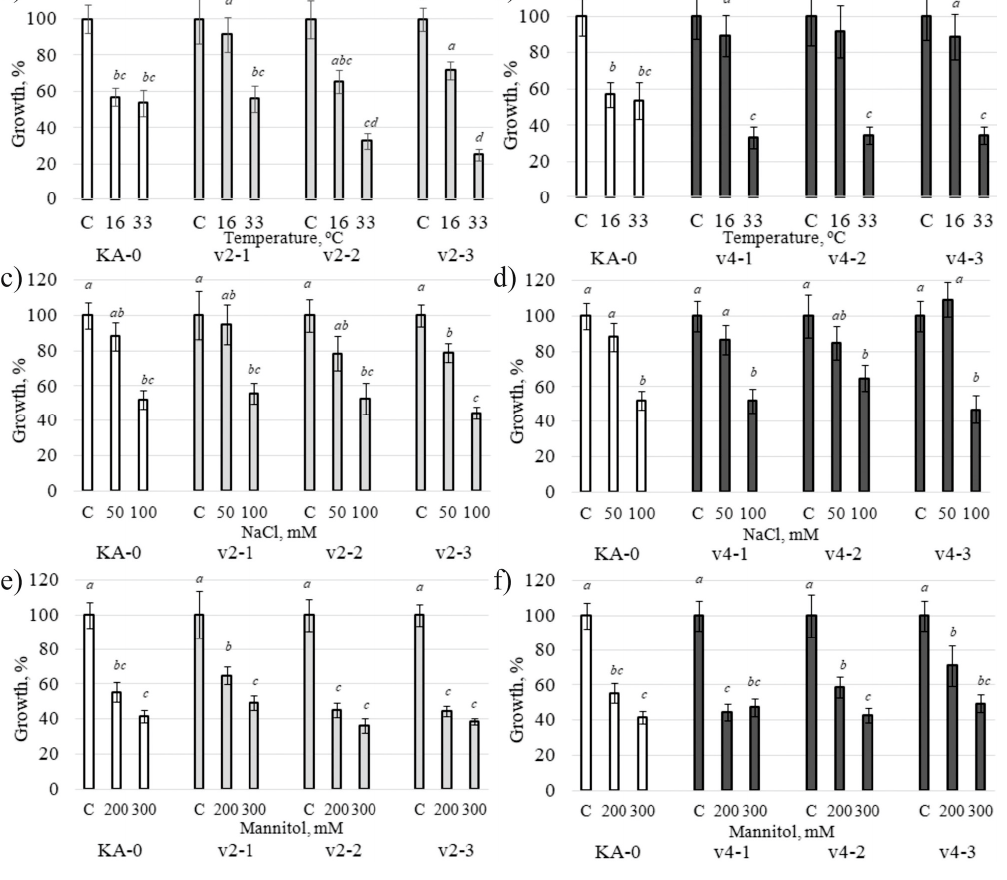
Figure 6. Influence of temperature ( a , b ), salt ( c , d ) and osmotic ( e , f ) stresses on the fresh biomass accumulation in the transgenic grapevine callus cell lines overexpressing the VaCML21v2 and VaCML21v4 splice variants. The average growth rates were assessed after 30 days of cultivation in the dark under the control (24 °C), cold stress (+16 °C), heat stress (+37 °C), salt stress (NaCl 50 and 100 mM), and high-mannitol (200 and 300 mM) conditions. v2-1, v2-2, v2-3— VaCML21v2 -transformed calli; v4-1, v4-2, v4-3— VaCML21v4 -transformed calli. KA-0—control cell culture transformed with the “empty” vector. The data are presented as the mean ± SE (two independent experiments with ten replicates each). Means followed by the same letter were not different using one-way analysis of variance (ANOVA), followed by the Tukey HSD multiple comparison test. A value of p ≤ 0.05 was considered as significant.